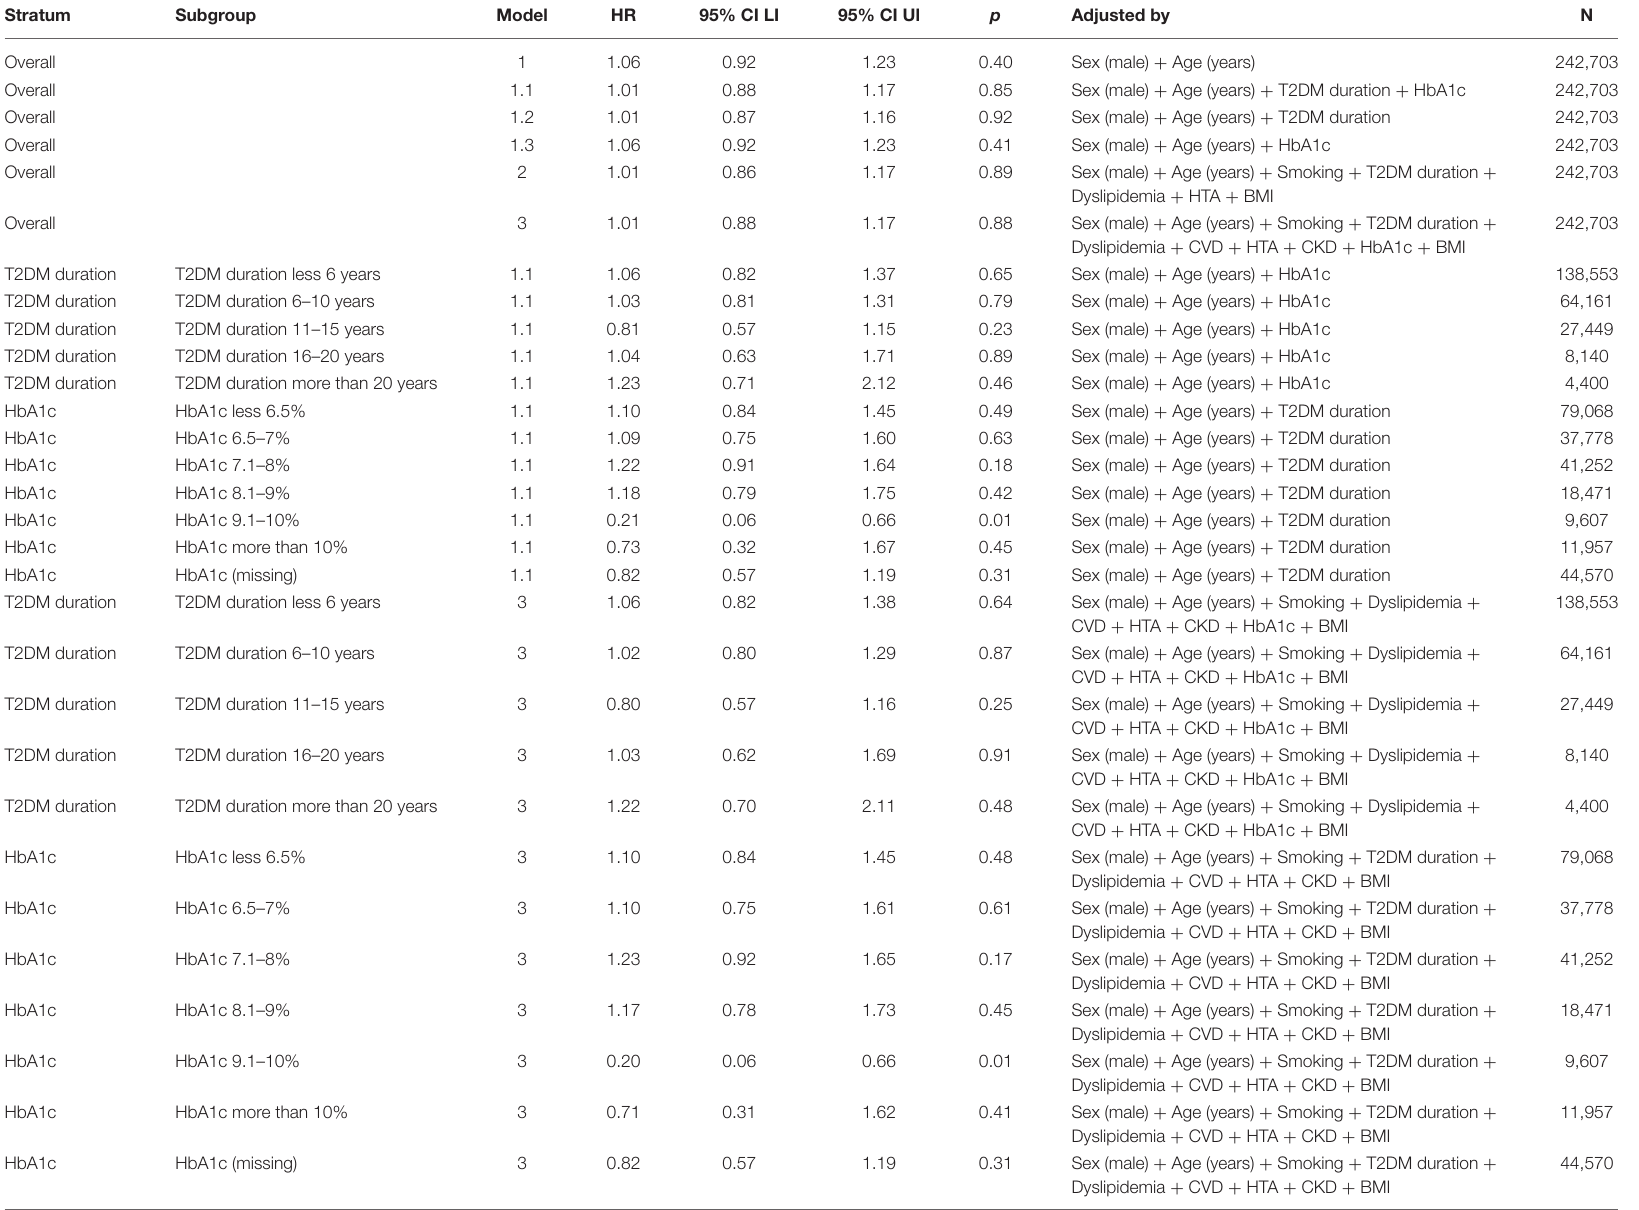
TABLE 6 | Sensitivity